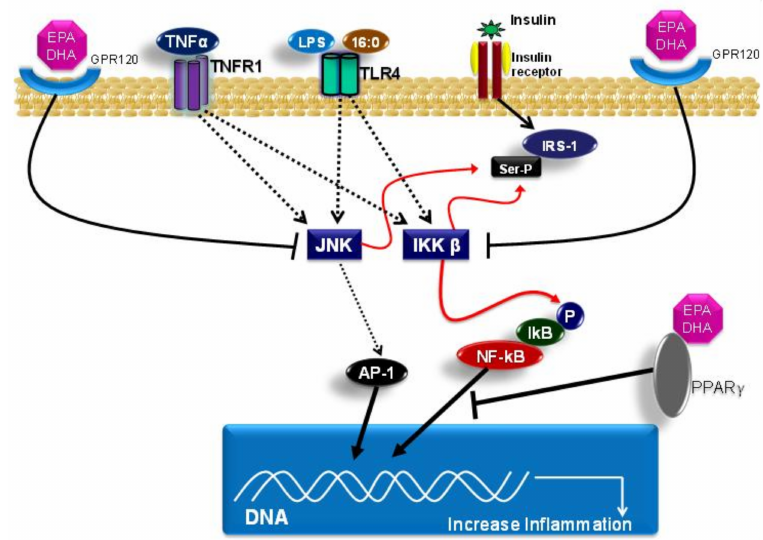
Figure 3. Molecular mechanism of the effects of saturated (16:0) and omega-3 polyunsaturated fatty acids (EPA, DHA) on the TLR4 and NFkB pathways. The arrows → indicate activation and the arrows indicate inhibition. Abbreviations: TNF α , Tumor necrosis factor ; TNFR1, Tumor necrosis factor receptor 1; LPS, Lipopolysaccharides; 16:0, palmitic acid; TLR4, Toll-like receptor 4; GPR120, G-protein coupled receptor 120; EPA, eicosapentaenoic acid; DHA, Docosahexaenoic acid; IRS-1, Insulin receptor substrate 1; Ser-P, phosphorylated serine residues; PPAR γ , Peroxisome proliferator-activated receptor gamma; JNK, c-Jun N-terminal kinases; IKK β , inhibitor of nuclear factor kappa-B kinase subunit beta; IkB, NFKB Inhibitor; P, phosphate; AP-1, Activator protein